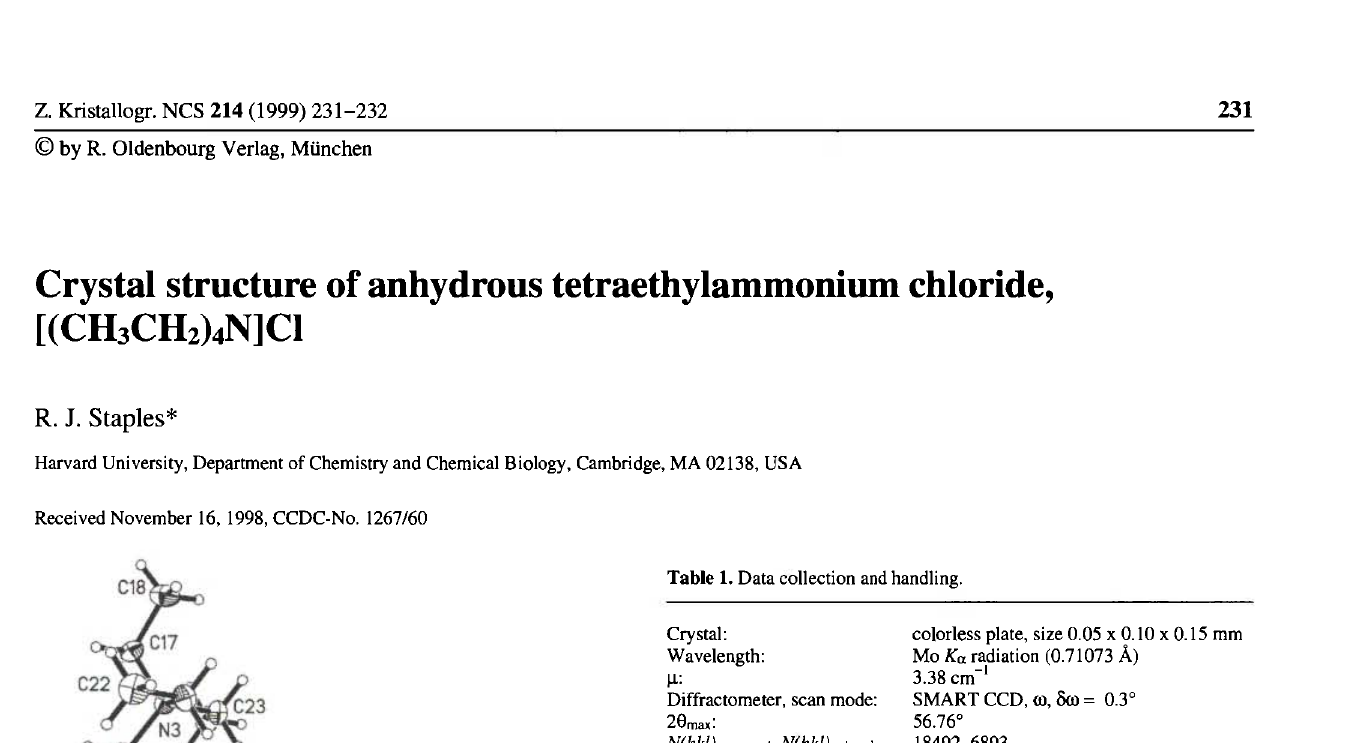
Table 2. Atomic coordinates and displacement parameters (in Ä 2